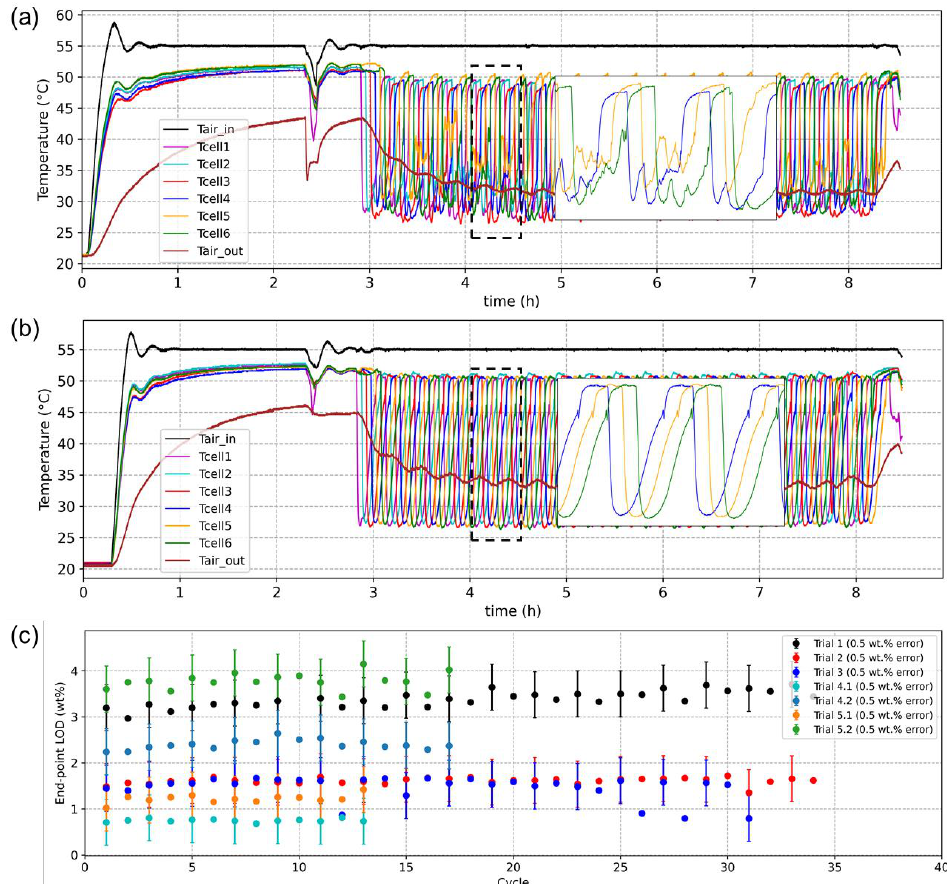
Figure 4. Inlet air temperature ( T air_in ), cell temperatures ( T cell ), and outlet air temperature ( T air_out ) of ( a ) Trial 1 and ( b ) Trial 2, and ( c ) average end-point LOD values in Cell3 and Cell5 of each cycle for Trial 1, 2, 3, 4.1, 4.2, 5.1, and 5.2.